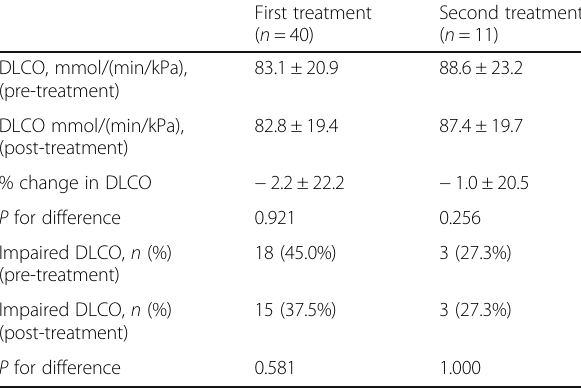
Table 2 Changes in lung carbon monoxide diffusion capacity after